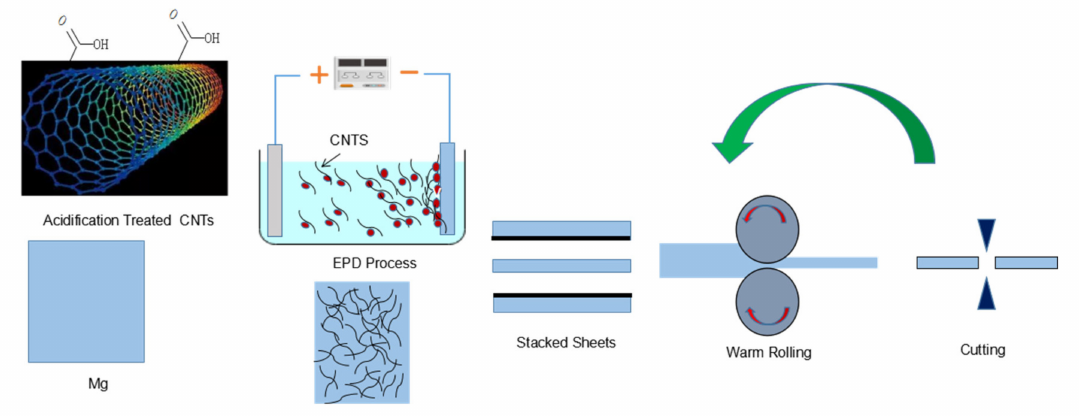
Figure 1. Schematic illustration for the preparation of composite materials with layered structure. Commercially pure magnesium (99.95 wt.%), with a thickness of 0.5 mm, and multi- walled CNTs (inner diameter: 2–10 nm, outer diameter: 20–40 nm, length: 10–30 µ m)